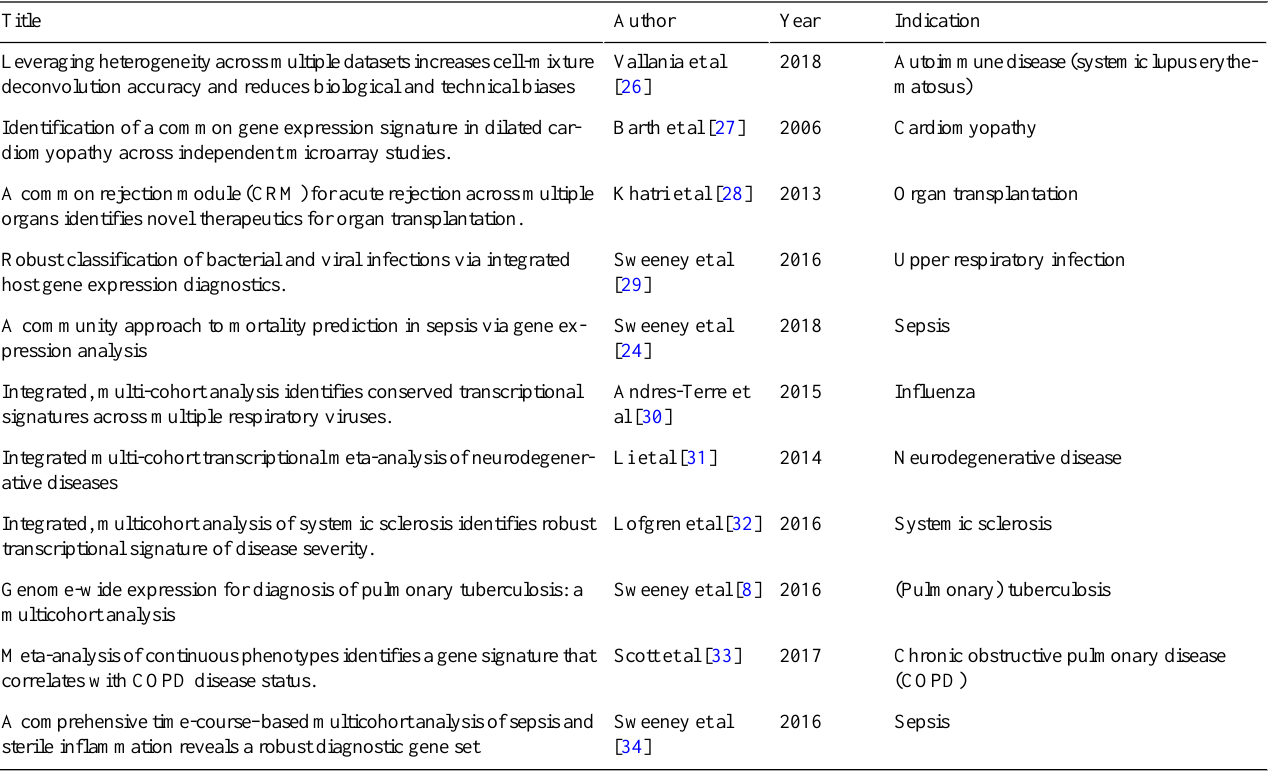
Table 2. Illustrative applications of user-constructed